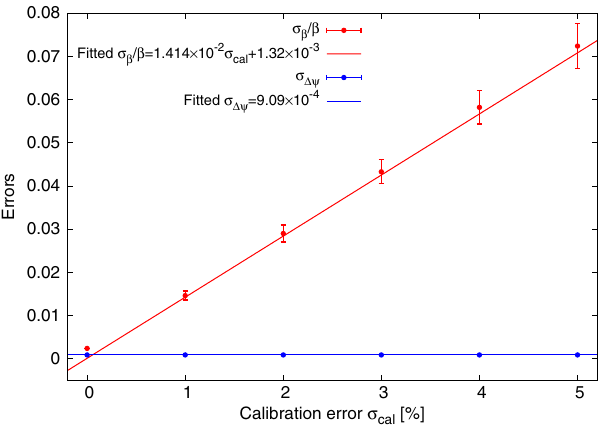
FIG. 13. Estimation of rms errors (cid:3) (cid:6) =(cid:6) and (cid:3) with various (cid:2) c . The estimation at each BPM random calibration errors (cid:3) cal is made by repeating the measure- random calibration error (cid:3) cal ment of (cid:6) and (cid:2) c 500 times with random Gaussian calibration errors added to each BPM. The error bars reflect the standard deviations at corresponding noise levels.